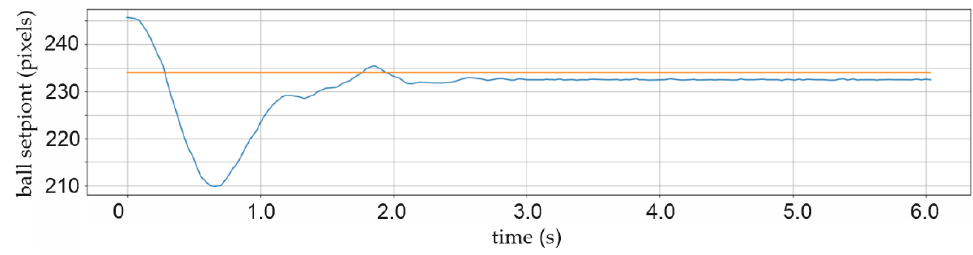
Figure 20. Experiment with residual ball position error-specific distance error.